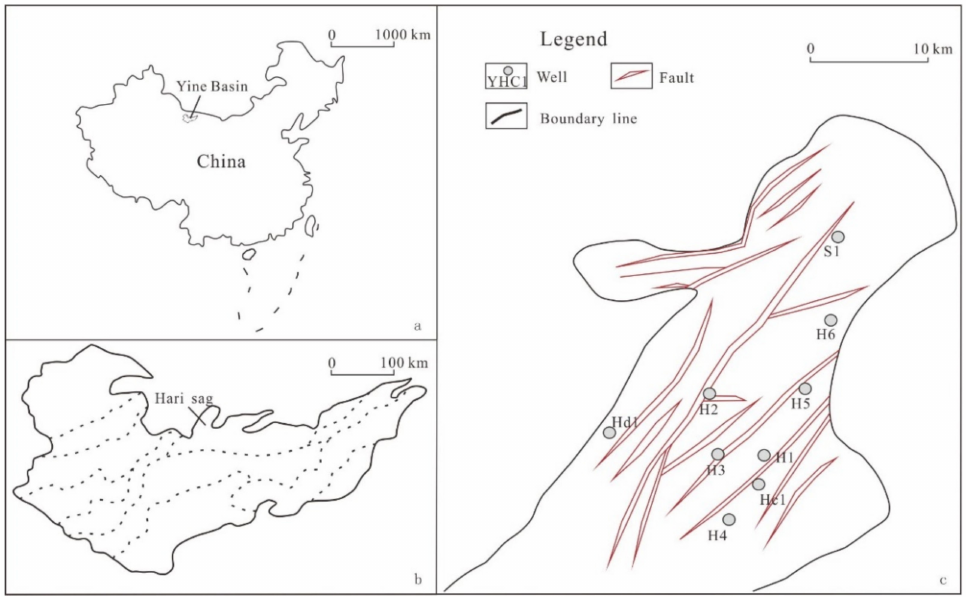
Figure 1. Tectonic location of Yin’e basin ( a ), tectonic location of the Hari sag ( b ), and well distribution ( c ) in the Hari